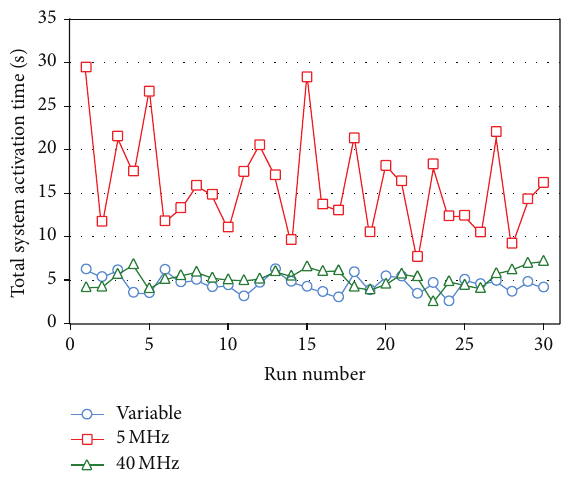
Figure 11: Line chart of the experiment result of transmitting 5 sessions in a 10-node network.